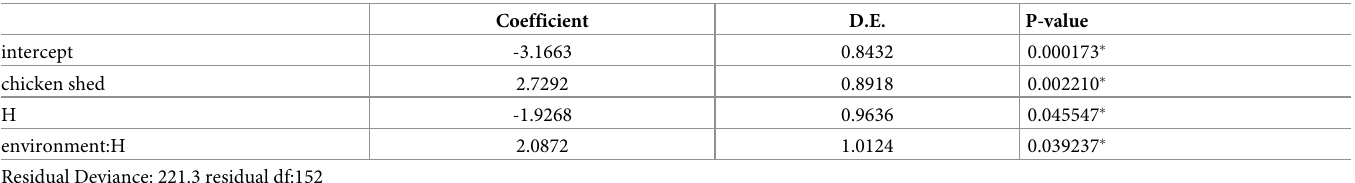
Table 5. Generalized linear mixed model of the variation of abundance in phlebotomine emergence at the plot level. The variables used in the model were environ- ments (chicken shed and below house), relative humidity of soil (H) and plot factor was included as random factor. Significance: p < 0.05 � . Model: abundance of emergent ~ environment: H + random effect